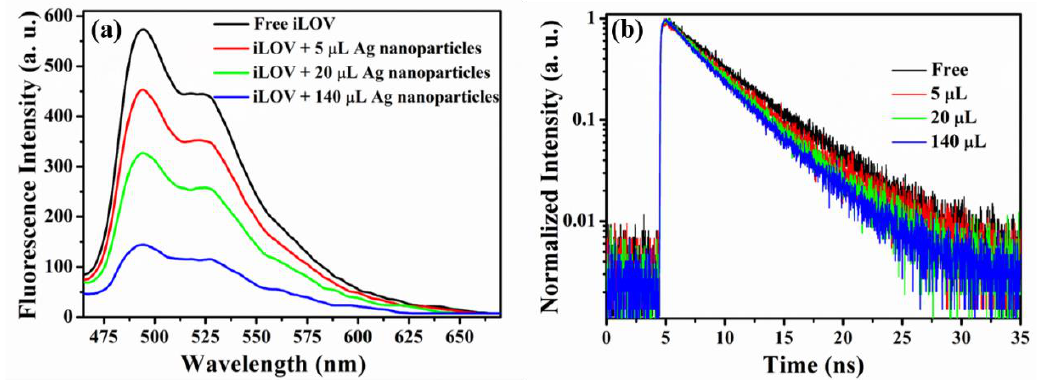
Figure 3. Normalized UV-vis absorption spectra ( a ) and size distribution ( b ) of Ag nanoparticles prepared at 0 °C, 35 °C, and 70 °C, respectively.